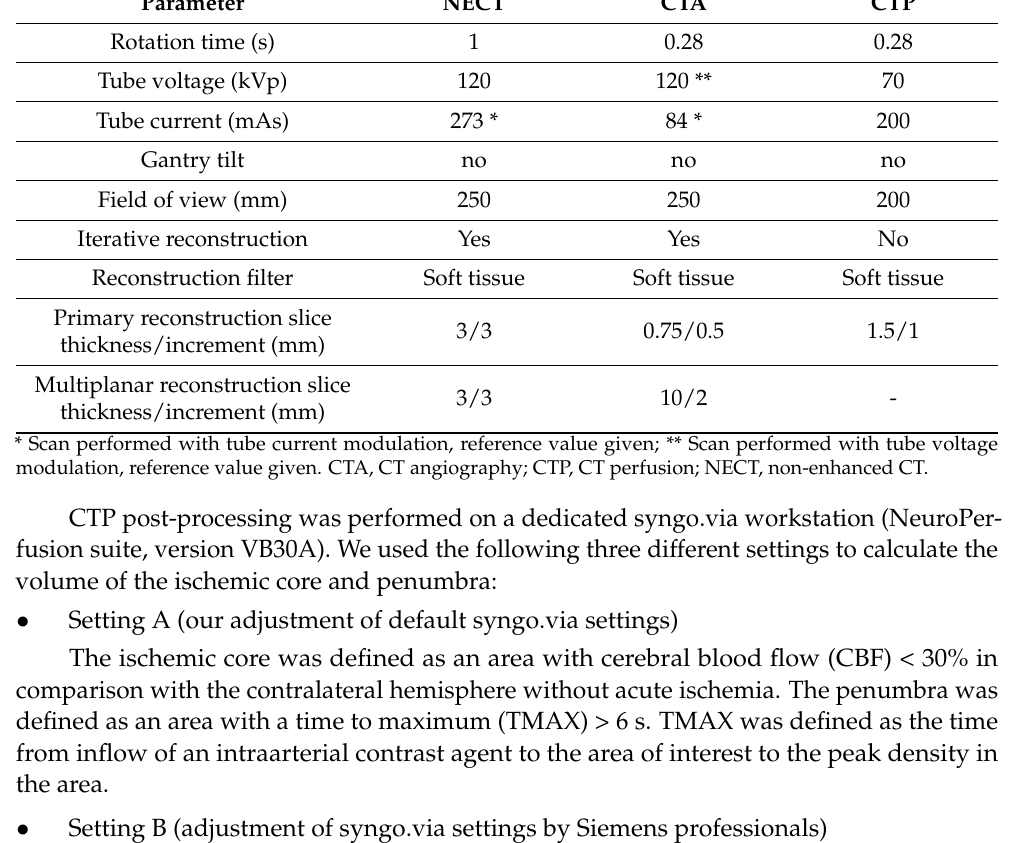
Table 1. Acquisition and reconstruction parameters of non-enhanced CT, CT angiography, and CT perfusion. Parameter NECT CTA CTP Rotation time (s) 1 0.28 0.28 Tube voltage (kVp) 120 120 ** 70 Tube current (mAs) 273 * 84 * 200 Gantry tilt no no no Field of view (mm) 250 250 200 Iterative reconstruction Yes Yes No Reconstruction filter Soft tissue Soft tissue Soft